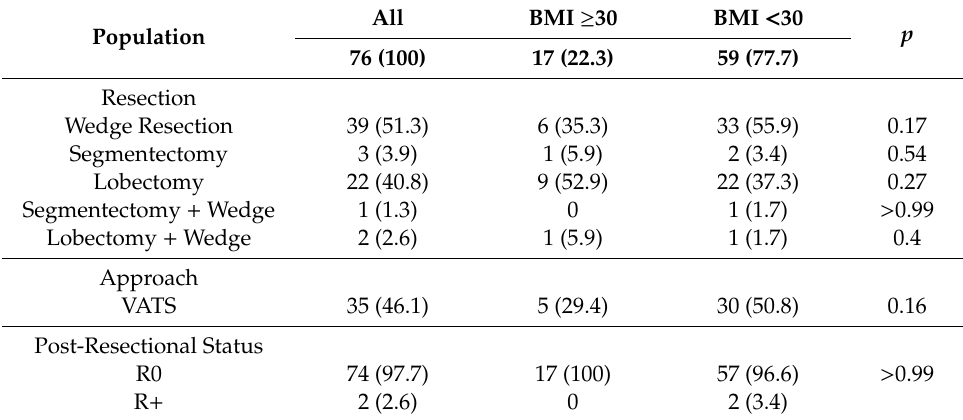
Table 2. Operative approach and kind of